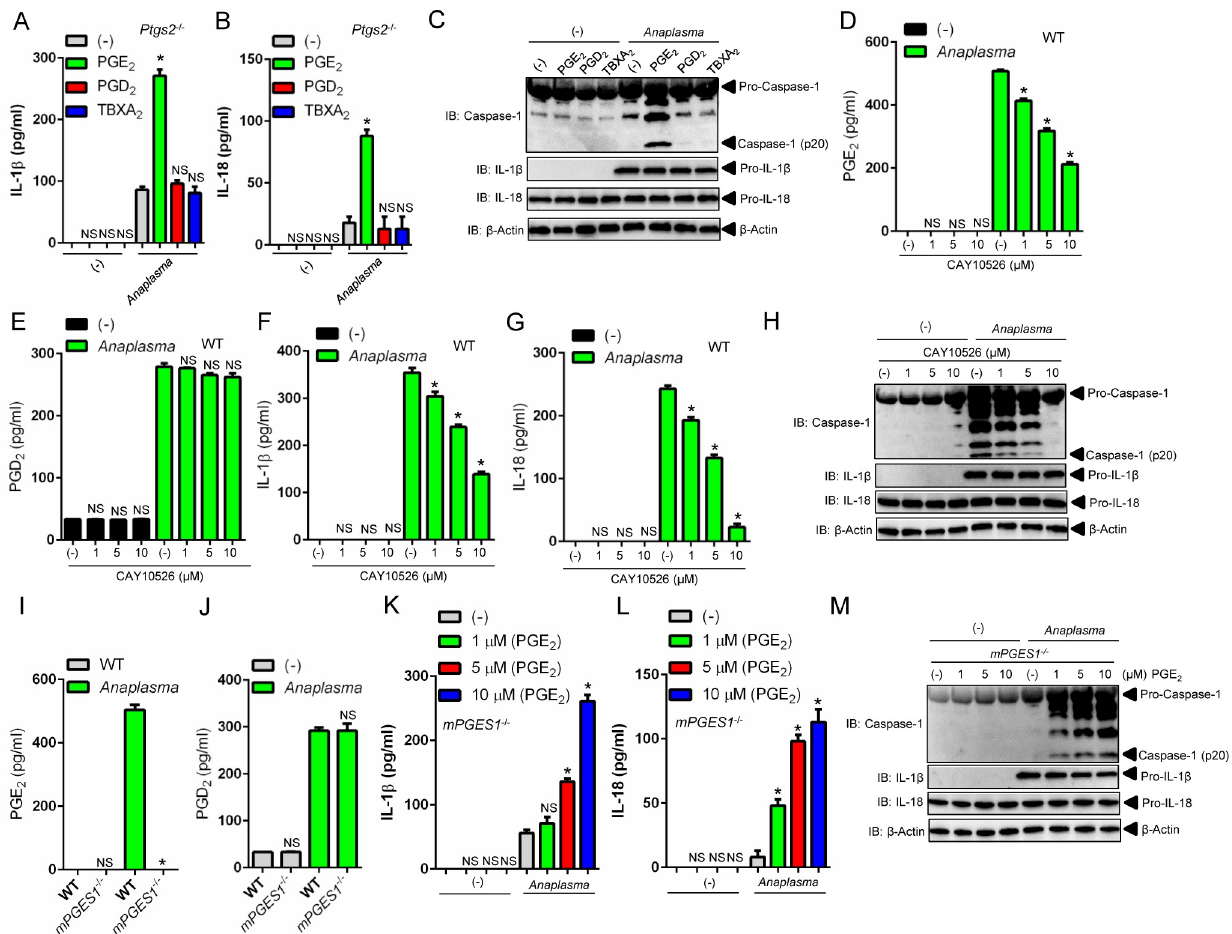
Fig 7. PGE 2 activates the A . phagocytophilum -induced NLRC4 inflammasome. (A-C) Ptgs2 -/- BMDMs (1 x10 6 cells) were infected with A . phagocytophilum (MOI50) for 4 hours followed by addition of PGE 2 (10 μ M), PGD 2 (10 μ M) or TBXA 2 (10 μ M) for 18 hours. (A) Levels of IL-1 β and (B) IL-18 in supernatants were measured by ELISA. (C) Caspase-1 autoproteolysis was measured in supernatants of infected cells. pro-IL- 1 β , pro-IL-18 and β -actin were detected in cell lysates with SDS-PAGE immunoblot (IB). (D-H) Wildtype (WT) BMDMs (1 x10 6 cells) were pre- treated with the specific inhibitor of mPGES1 (CAY10526 – 1 μ M) for 30 minutes followed by A . phagocytophilum infection (MOI50) for 18 hours. The levels of (D) PGE 2 , (E) PGD 2 , (F) IL-1 β and (G) IL-18 in the culture supernatants were measured by ELISA. (H) Caspase-1 p20 autoproteolysis in culture supernatants. pro-IL-1 β , pro-IL-18 and β -actin were detected in cell lysates with a SDS-PAGE immunoblot. (I-J) WT and mPGES1 -/- BMDMs (1 x10 6 cells) were infected with A . phagocytophilum (MOI50) for 18 hours. The levels of (I) PGE 2 and (J) PGD 2 were measured in culture supernatants by ELISA. (K-M) mPGES1 -/- BMDMs (1 x10 6 cells) were infected with A . phagocytophilum for 4 hours followed by addition of PGE 2 at indicated concentrations for 18 hours. (K) IL-1 β and (L) IL-18 levels in cell culture supernatants were measured by ELISA. (M) Caspase-1 autoproteolysis in cell culture supernatants. pro-IL-1 β , pro-IL-18 and β -actin in cell lysates were detected